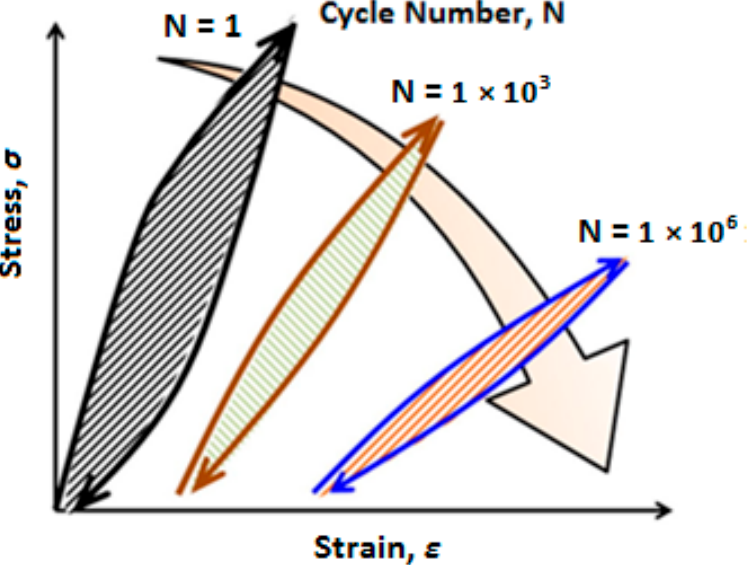
Figure 1. A schematic illustration of dissipated hysteresis thermal energy variations of a cyclically loaded PMC structure, adapted with permission from Ref. [5]. Copyright © 2017 Elsevier.